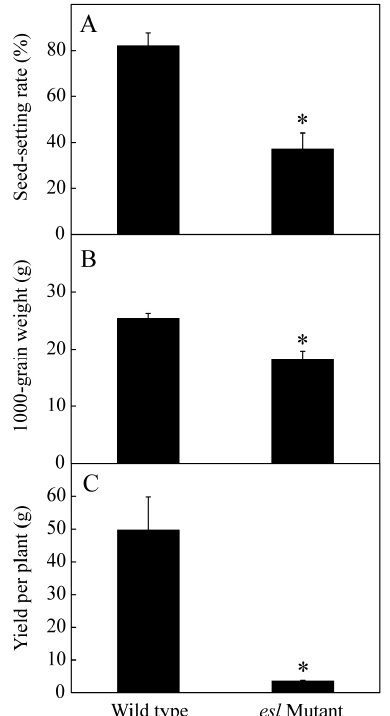
Figure 1. Genotype-dependent differences in the ( A ) seed-setting rate, ( B ) 1000-grain weight, and ( C ) yield per plant for the two rice genotypes. Vertical bars represent standard errors ( n = 3). The asterisks represent significant differences between the early senescence leaf ( esl ) mutant and its wild-type cultivar (* p < 0.05).